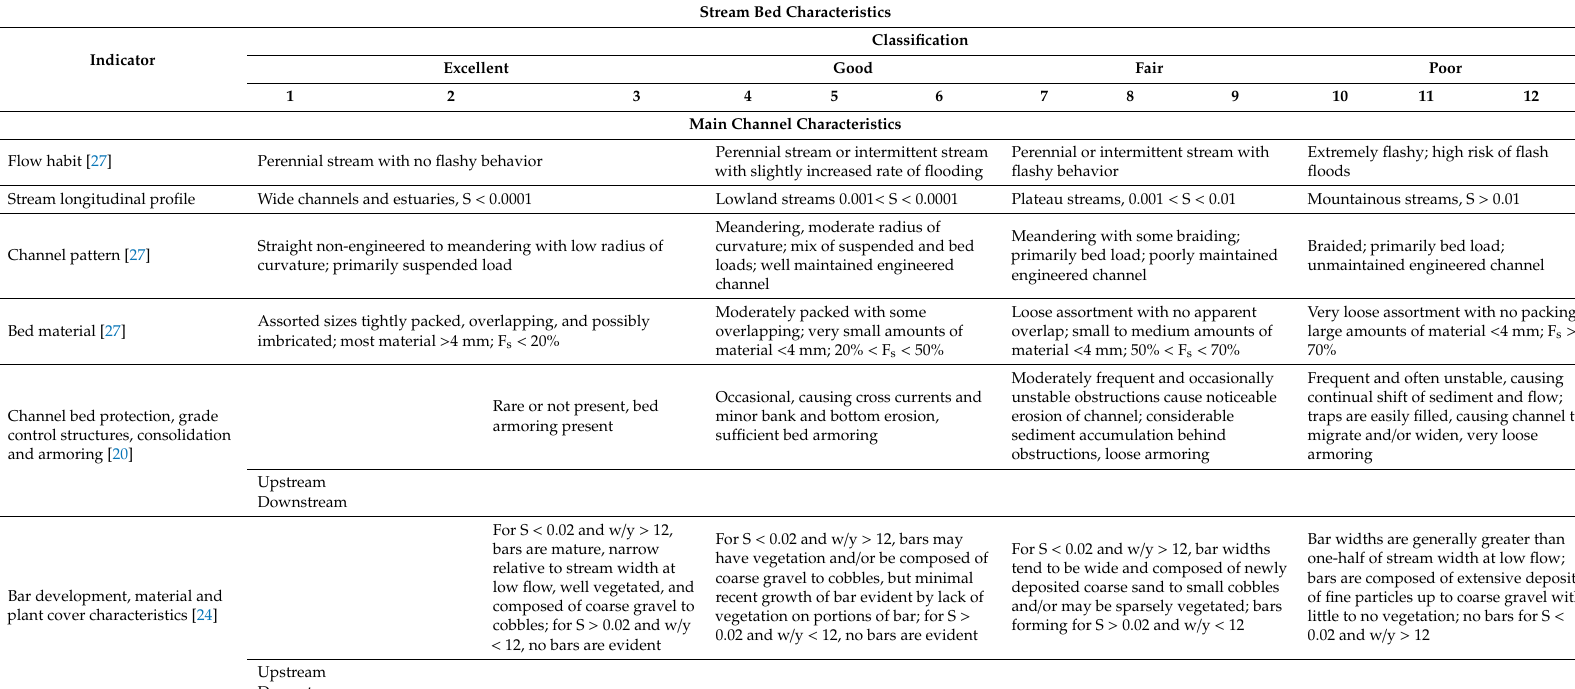
Table 3. Stream bed